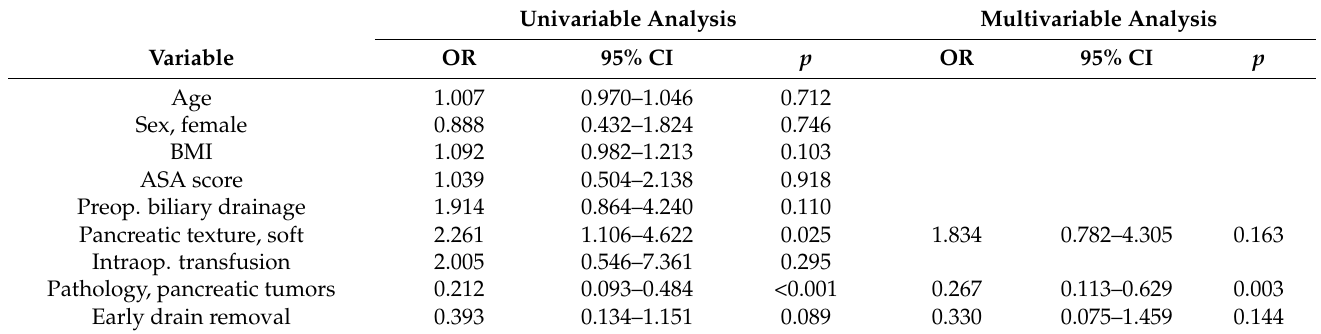
Table 4. Binary logistic regression analysis for CR-POPFs in patients with POD1 DFA < 5000 IU ( n =